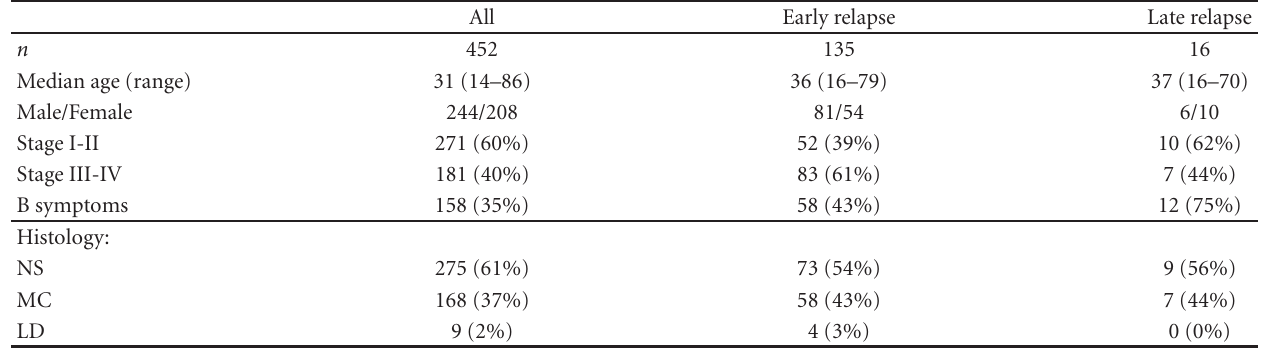
Table 1: Patients characteristics of HL in complete remission after first-line chemotherapy.